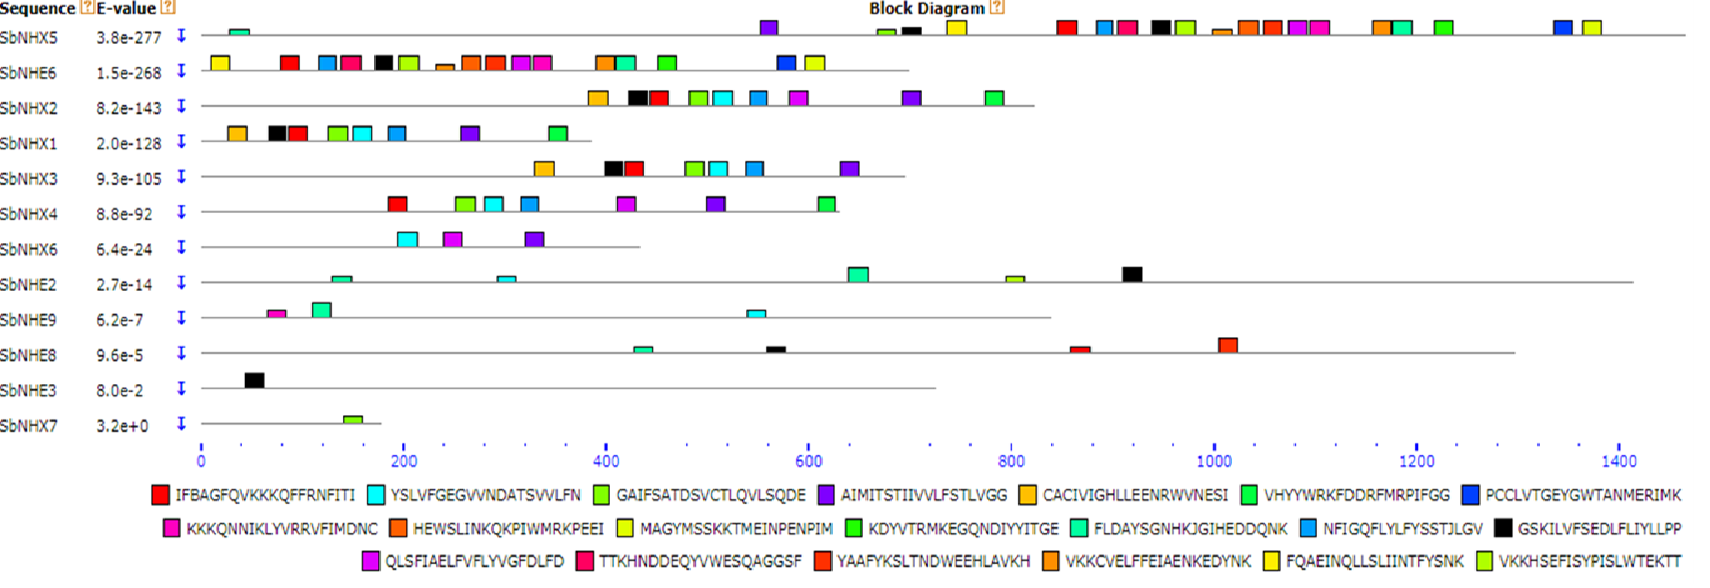
Figure 2. Conserved motif analysis of SbNHX/NHE proteins. Amiloride motif (LLFIYLLPPI) is represented in black. Sb: Sorghum bicolor ; NHX: sodium proton antiporter; NHE: sodium proton exchanger.